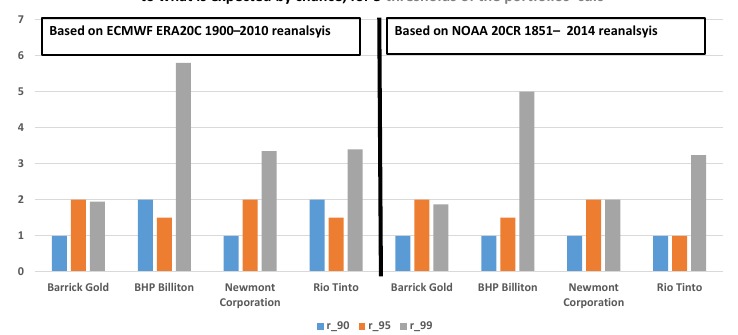
Figure 6. Ratio of actual number of events in excess of at-site, 100-year, 1-day extreme rainfall for a portfolio relative to what is expected by chance based on the Poisson distribution, for three thresholds of the portfolio